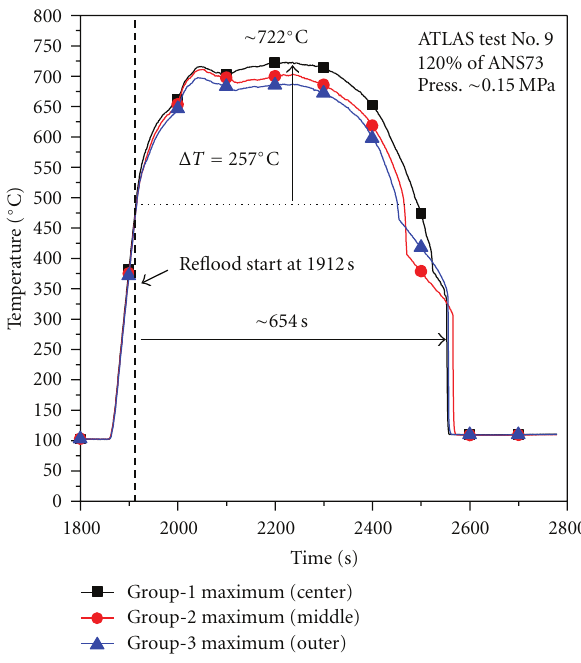
Figure 6: Maximum heater rod surface temperature variation of the core during LB-CL-09.